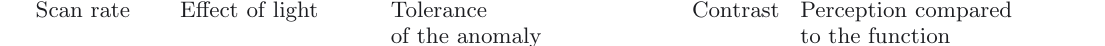
Table 1. An example of a criteria/level